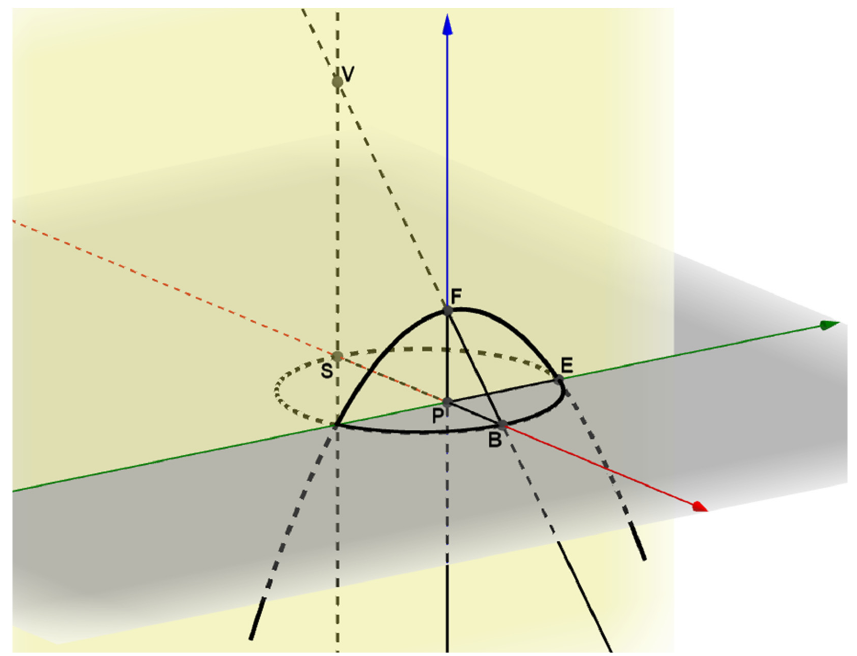
Figure 8. Following steps of Wallis’ construction.